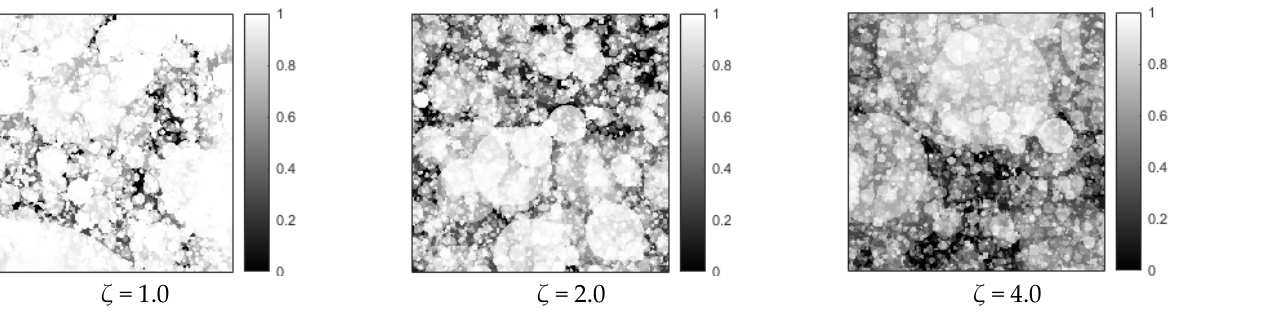
Figure 7. Multifractal porous materials synthesized by the two-parameter binomial multiplicative cascades.